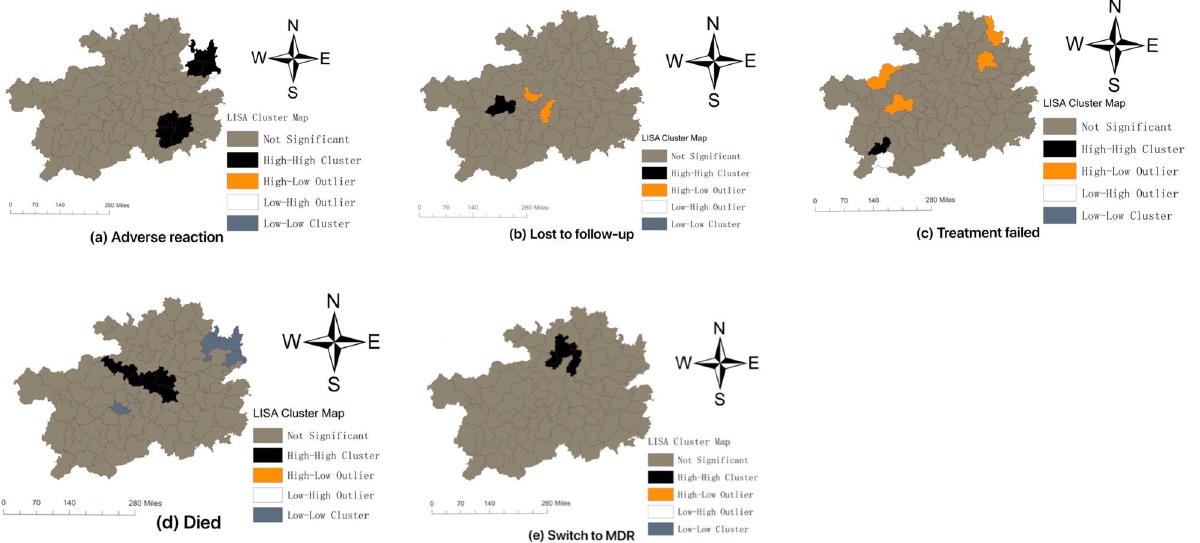
Figure 4. Maps of the local indicators of spatial association (LISA) of adverse outcomes of TB in Guizhou during 2013–2018. ( a ) Spatial clusters of rate of adverse reaction; ( b ) Spatial clusters of rate of lost to follow-up; ( c ) Spatial clusters of rate of treatment failed; ( d ) Spatial clusters of rate of died; ( e ) Spatial clusters of rate of switch to